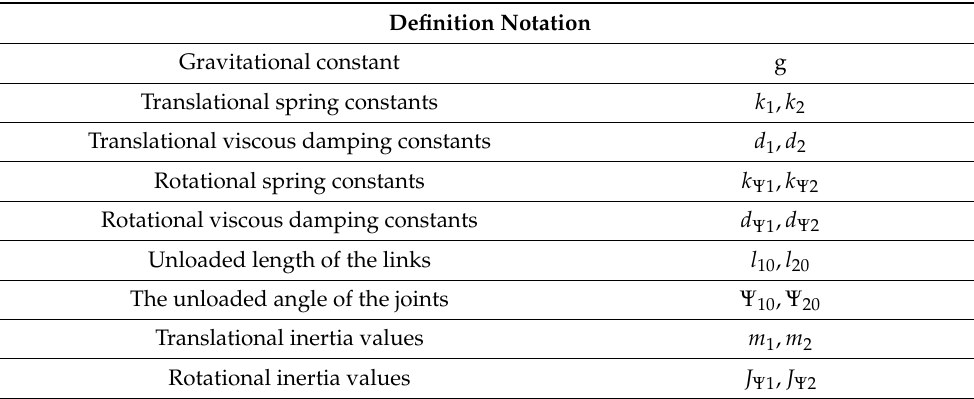
Table 1. The system parameters define the flexible robot arm. Definition